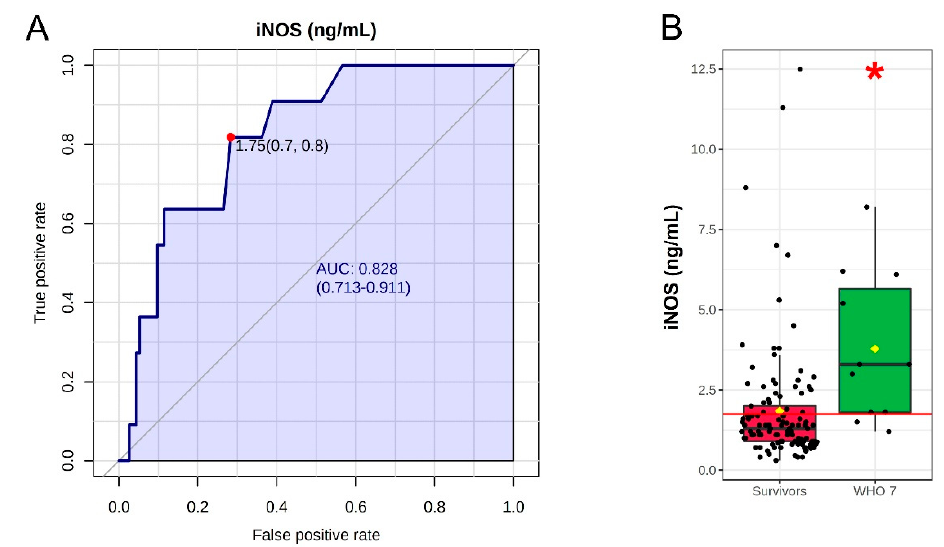
Figure 2. ( A ) Univariate ROC curve analysis for iNOS. ( B ) Box plot of iNOS values in corticosteroid- untreated patients of both waves with WHO 3–6 (survivors, n = 113) and WHO 7 (deceased patients, n = 11). The red line in box plot represents the best cut-off value. * p = 0.0004 .